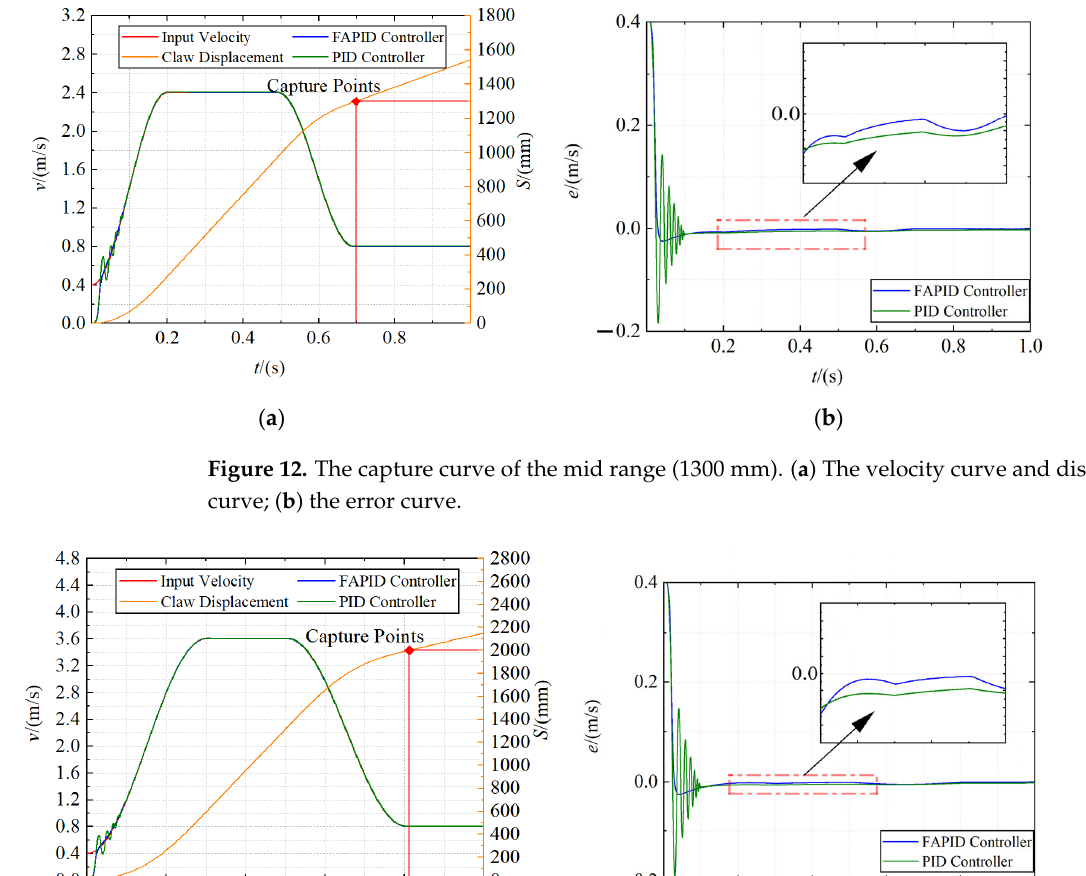
Figure 11. The capture curve of the close range (600 mm). ( a ) The velocity curve and displacement curve; ( b ) the error curve.